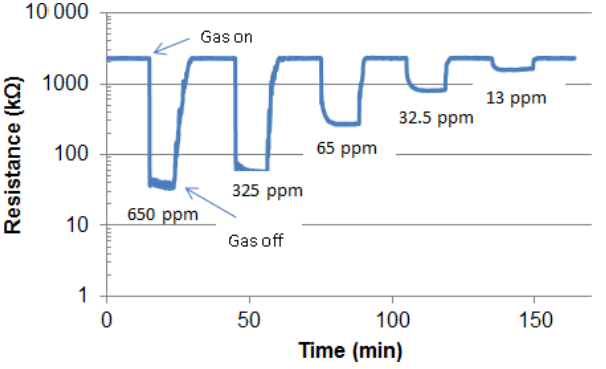
Figure 3. Dependence of electrical resistance change in MWCNTs/SnO 2 sensors on operating temperature in the air.